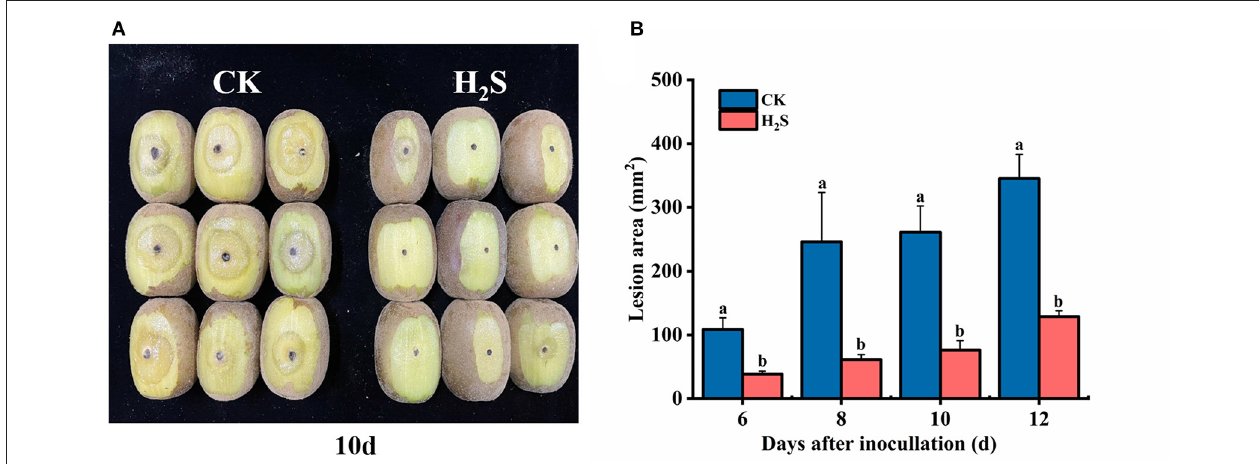
FIGURE 1 | Infection symptoms (A) in kiwifruit at 10 days after inoculation with Botryosphaeria dothidea . The lesion area (B) of kiwifruit [control (CK), H 2 S] with inoculation of B . dothidea during storage at 25 ◦ C. Vertical bars represented the standard errors. Letters indicate significant differences ( P < 0.05).